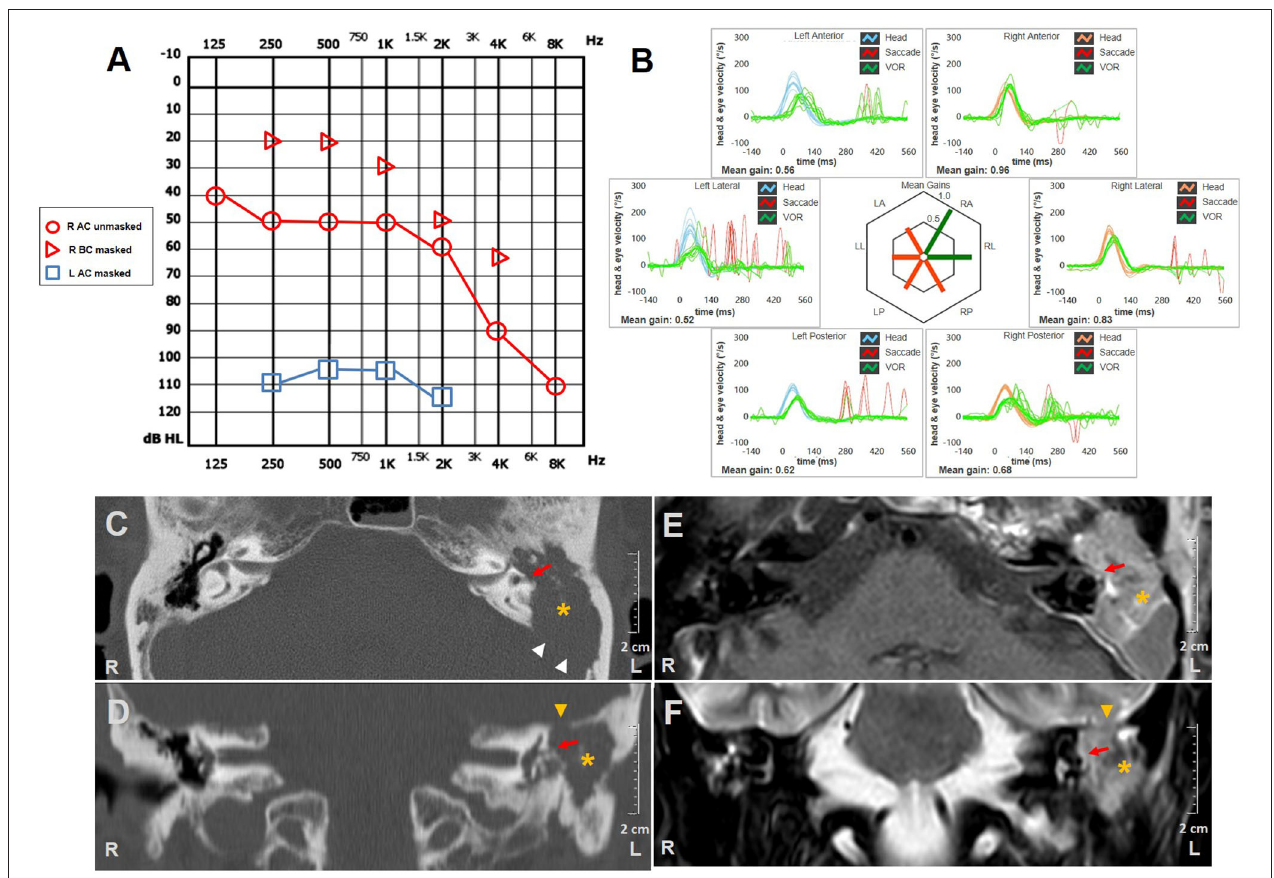
FIGURE 1 | Instrumental and radiological data of case one. (A) Audiometry showing mixed HL on the right side and profound HL on the left. (B) vHIT measurements. Blue lines represent head impulses exciting left SCs, orange lines correspond to impulses for right SCs, green lines represent eye movements induced by the activation of VOR following each impulse and red lines correspond to corrective saccades. Mean value of VOR-gain (eye velocity/head velocity) is reported for each SC. The hexagonal plot in the center of the figure summarizes mean VOR-gains for each SC; normal gains are shown in green and deficient gains are in red. A global canal hypofunction on the left and a slight reduction of the VOR-gain for contralateral PSC with overt saccades could be clearly observed. Axial (C) and coronal (D) images of temporal bones CT scans completed with axial T1-weighted (E) and coronal T2-weighted (F) gadolinium-enhanced brain MRI showing soft tissue density ( yellow asterisks ) within left external/middle-ear and mastoid cavity disrupting surrounding structures. Ossicular chain is not detectable. Bony erosion areas at the posterior fossa ( white arrowheads ) and middle fossa floor ( yellow arrowheads ) with dural infiltration are highlighted. Otic capsule erosion at the left HSC is indicated with red arrows . AC, air conduction; BC, bone conduction; CT, computed tomography; HL, hearing loss; HSC, horizontal semicircular canal; L, left; LA, left anterior; LL, left lateral; LP, left posterior; MRI, magnetic resonance imaging; PSC, posterior semicircular canal; R, right; RA, right anterior; RL, right lateral; RP, right posterior; SC, semicircular canal; vHIT, video-head impulse test; VOR, vestibulo-ocular